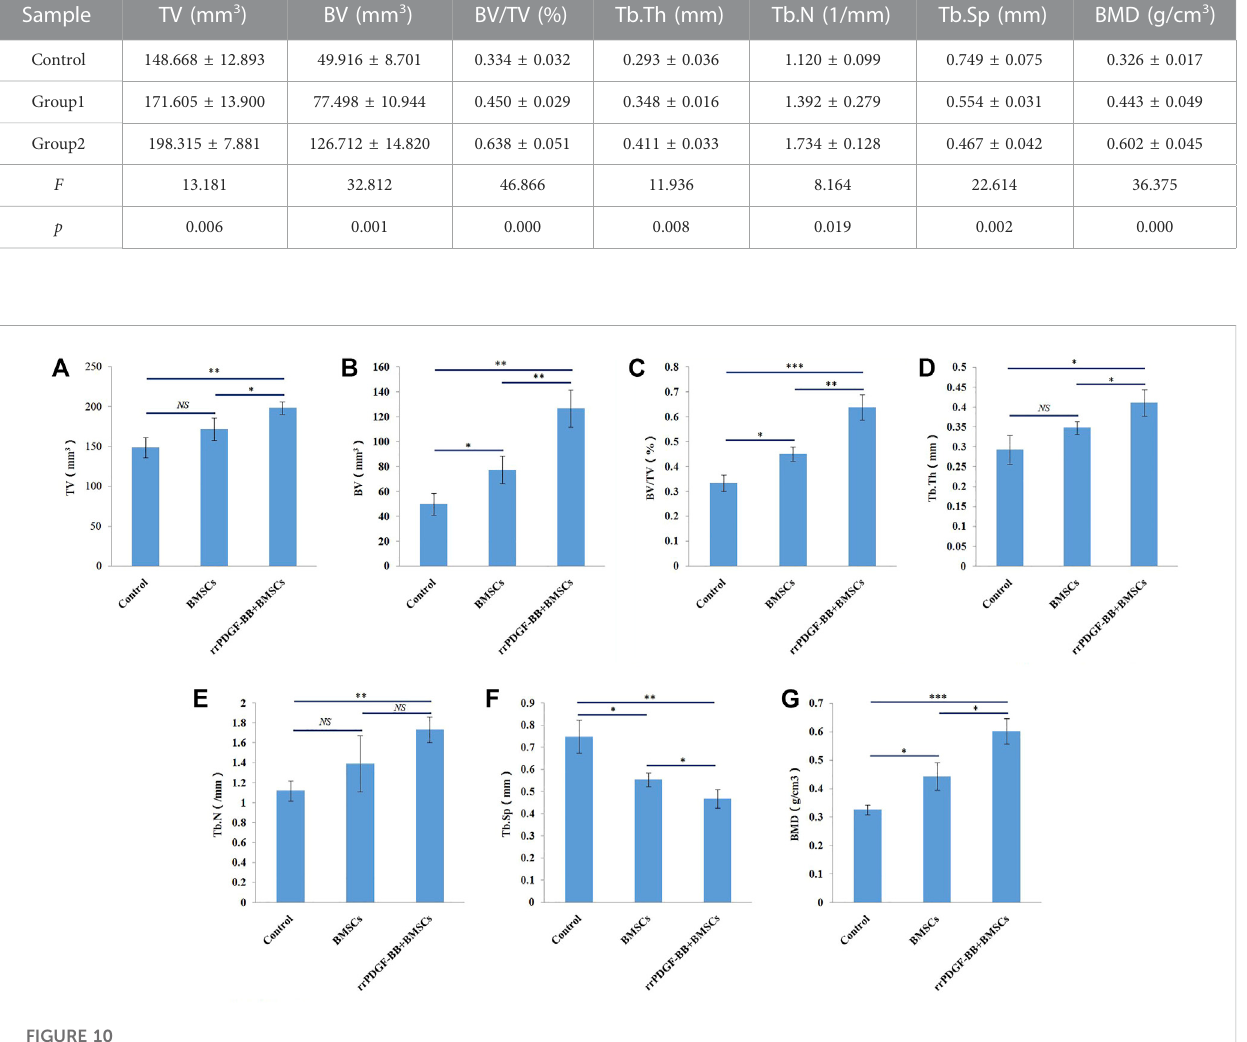
FIGURE 10 Micro-CTparametersofratfemoraatweek8. (A) Micro-CTanalysesoftissuevolume(TV)ineachgroup. (B) Micro-CTanalysesofbonevolume(BV) in each group. (C) Micro-CT analyses of percent bone volume (BV/TV) in each group. (D) Micro-CT analyses of trabecular thickness (Tb.Th) in each group. (E) Micro-CT analyses oftrabecular number (Tb.N) in each group. (F) Micro-CTanalysesof trabecular separation (Tb.Sp) ineach group. (G) Micro-